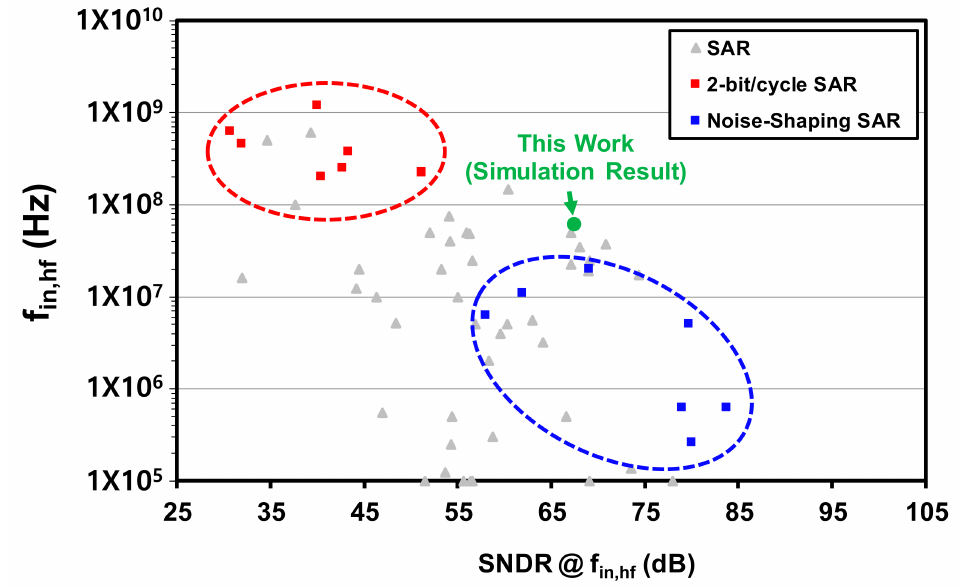
Figure 1. Bandwidth versus resolution of SAR-based ADCs [4] and simulation result of proposed ADC.